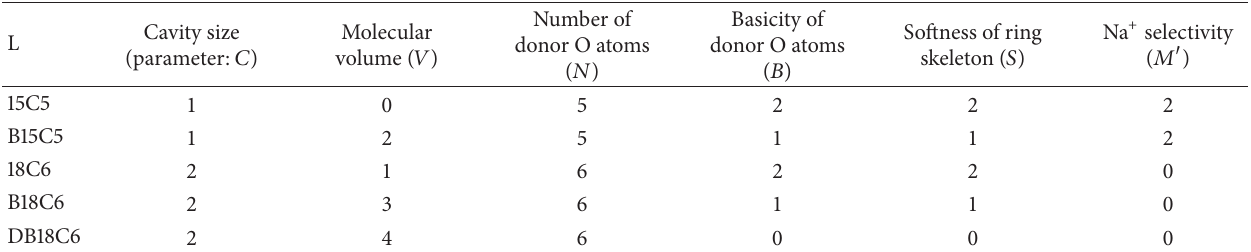
Table 3: A measure of basic parameters for a comparison between